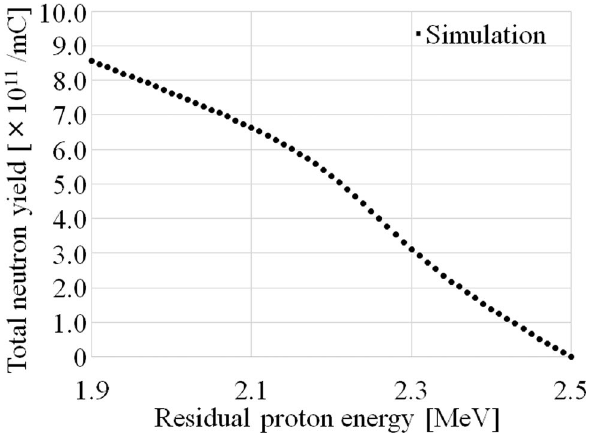
Figure 3. Total neutron yield as a function of the residual proton energy after passing through the Li target. The incident proton energy was 2.5 meV.